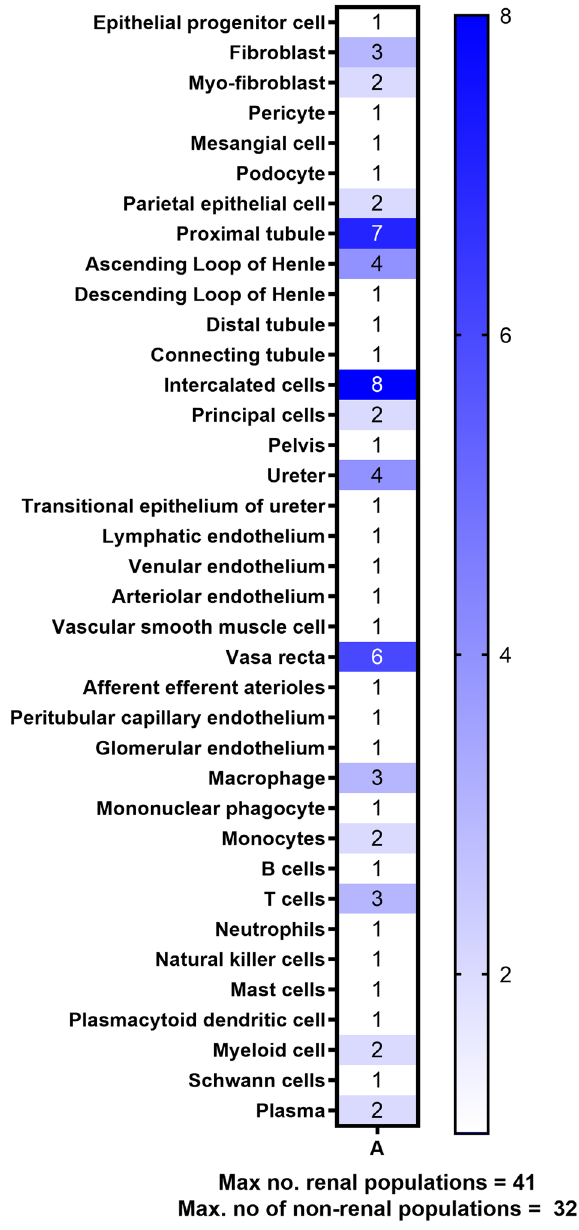
Fig. 3 The variety of different renal cell populations identi fi ed by single-cell RNA sequencing to date. All cell types detected (accumulated) by all discussed scRNA sequencing publications. The number indicates the highest number of clusters distinguished by one or more of the discussed publications and with this, the total sum of populations was calculated. For the adult kidney, 41 renal and 32 non-renal populations were